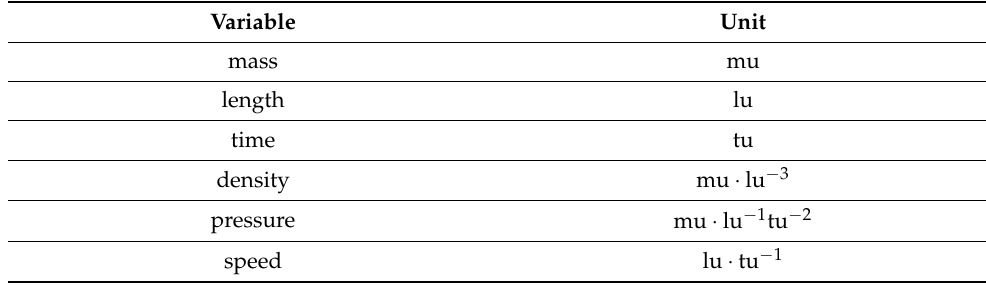
Table 1. The variable units in the